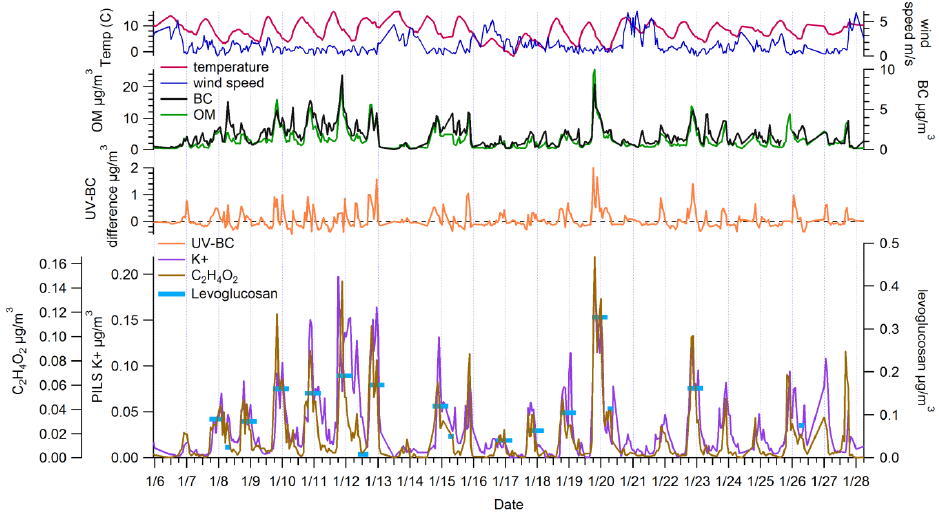
Figure 1. Time series of temperature, wind speed, Aethalometer black carbon (BC), Aerosol Mass Spectrometer (AMS) organic matter (OM), Aethalometer UV-BC difference, PILS K + , AMS C 2 H 4 O 2+ , and levoglucosan from quartz fiber filters at Fyfe during January 2008 (all units in µg/m 3 except temperature in degrees C and wind speed in m/s).